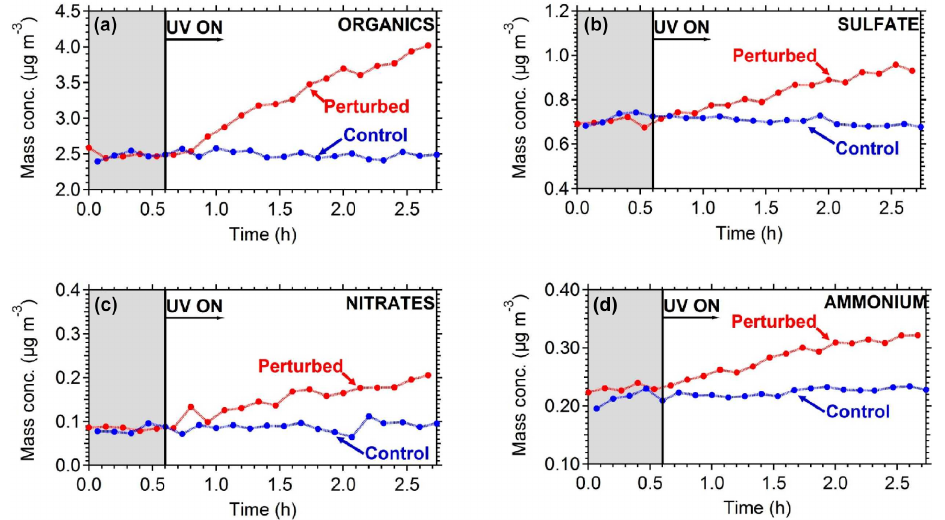
Figure 8. The particle wall-loss-corrected concentrations of the major PM 1 components measured by the AMS (a) organics, (b) sulfate, (c) nitrates, and (d) ammonium. The shaded area indicates that the chambers were dark. Data have been corrected for the collection efficiency (CE = 0.6).